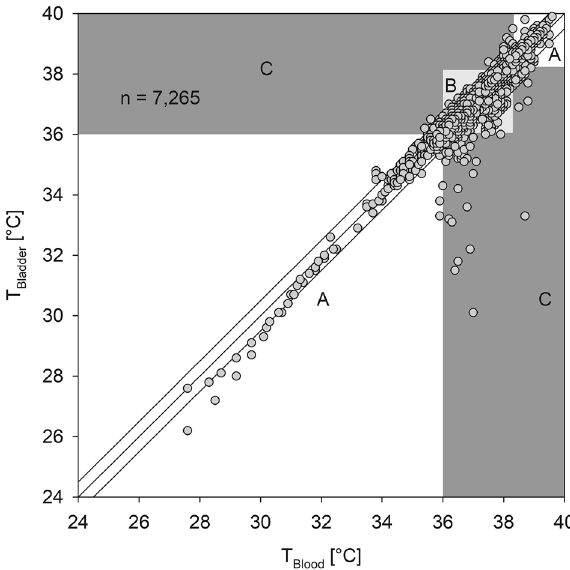
Figure 4. Error grid analysis of bladder temperature (T Bladder ) against blood temperature (T Blood ). Zone A is drawn in white, Zone B in grey and Zone C in dark